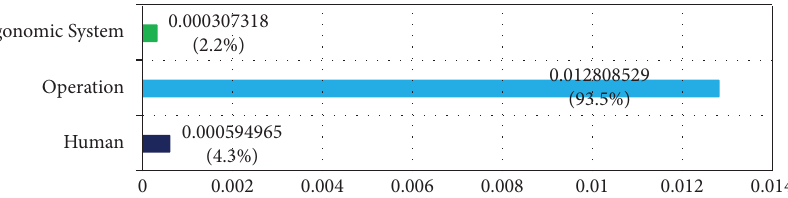
Figure 11: Error probabilities of Level 1